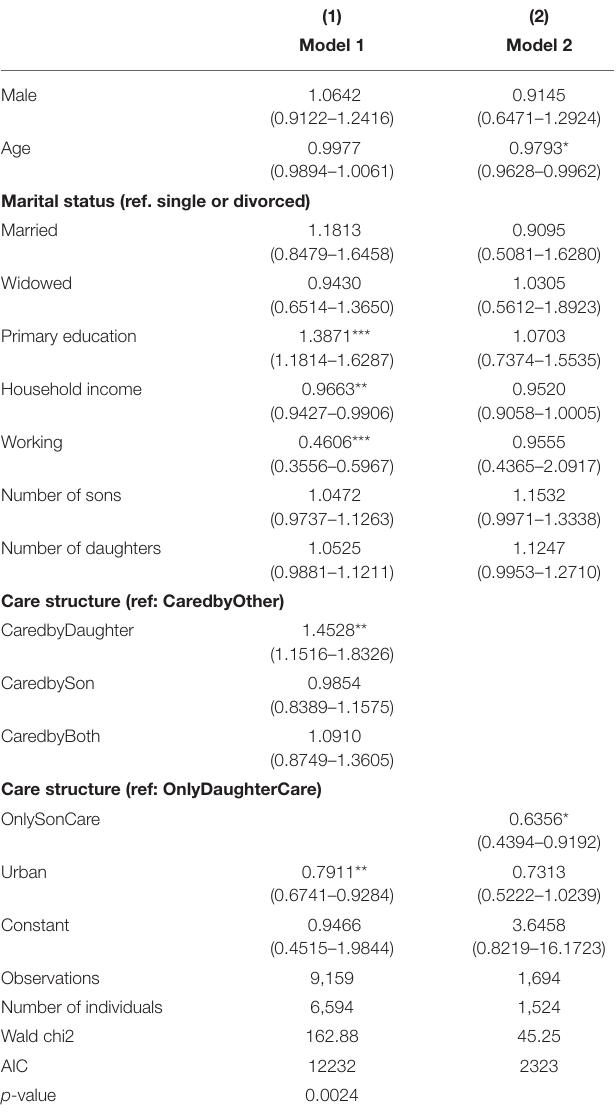
TABLE 3 | Random-effects logistic regression models for self-reported health and care provided by son and